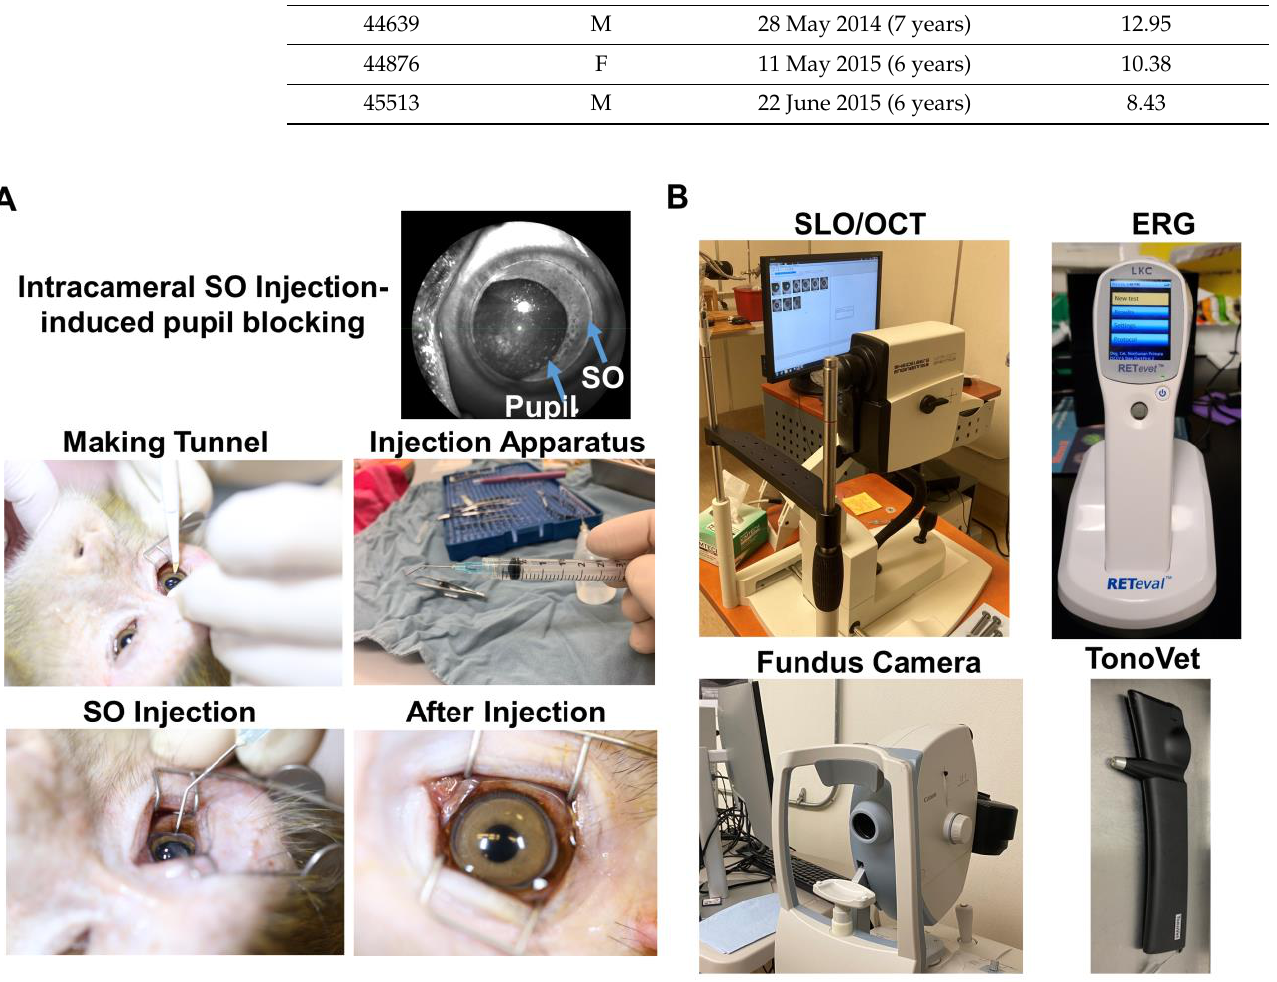
Figure 1. Intracameral SO injection and in vivo assays of rhesus macaque monkey eyes. ( A ) The procedures of SO intracameral injection in monkey eye; ( B ) The equipment used for in vivo assays, including SLO/OCT, ERG, fundus imaging, and TonoVet for IOP measurement.